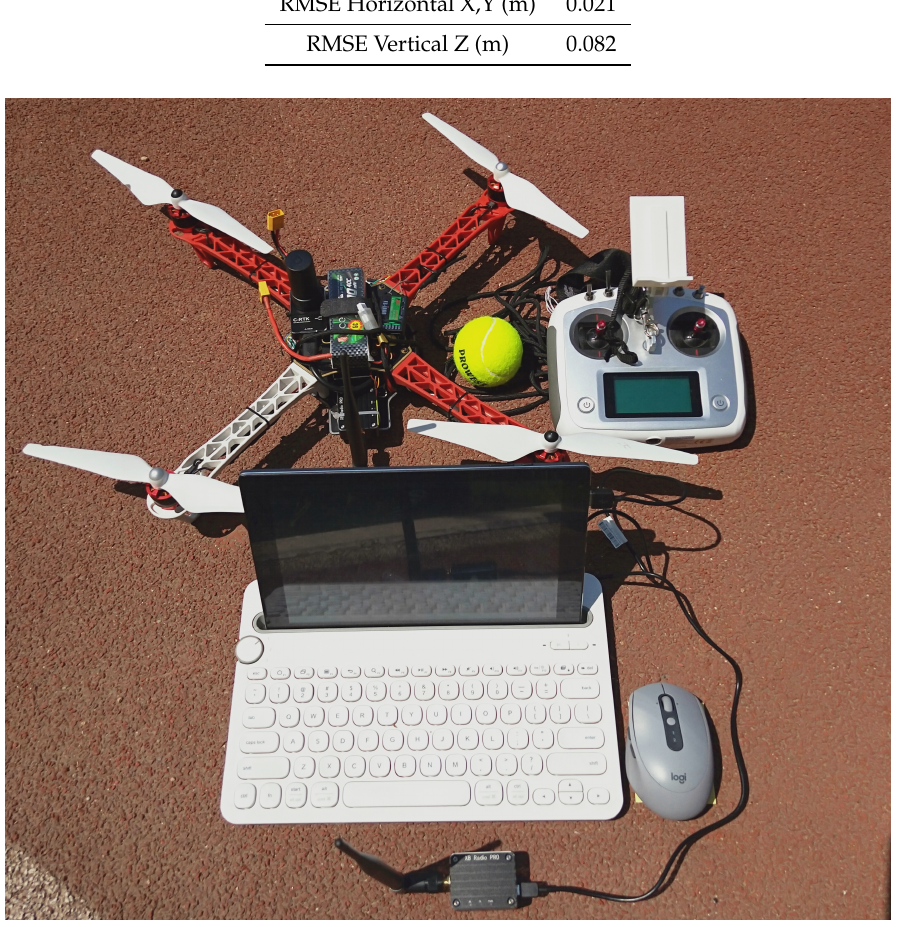
Figure 5. UAV transportation system used in the field